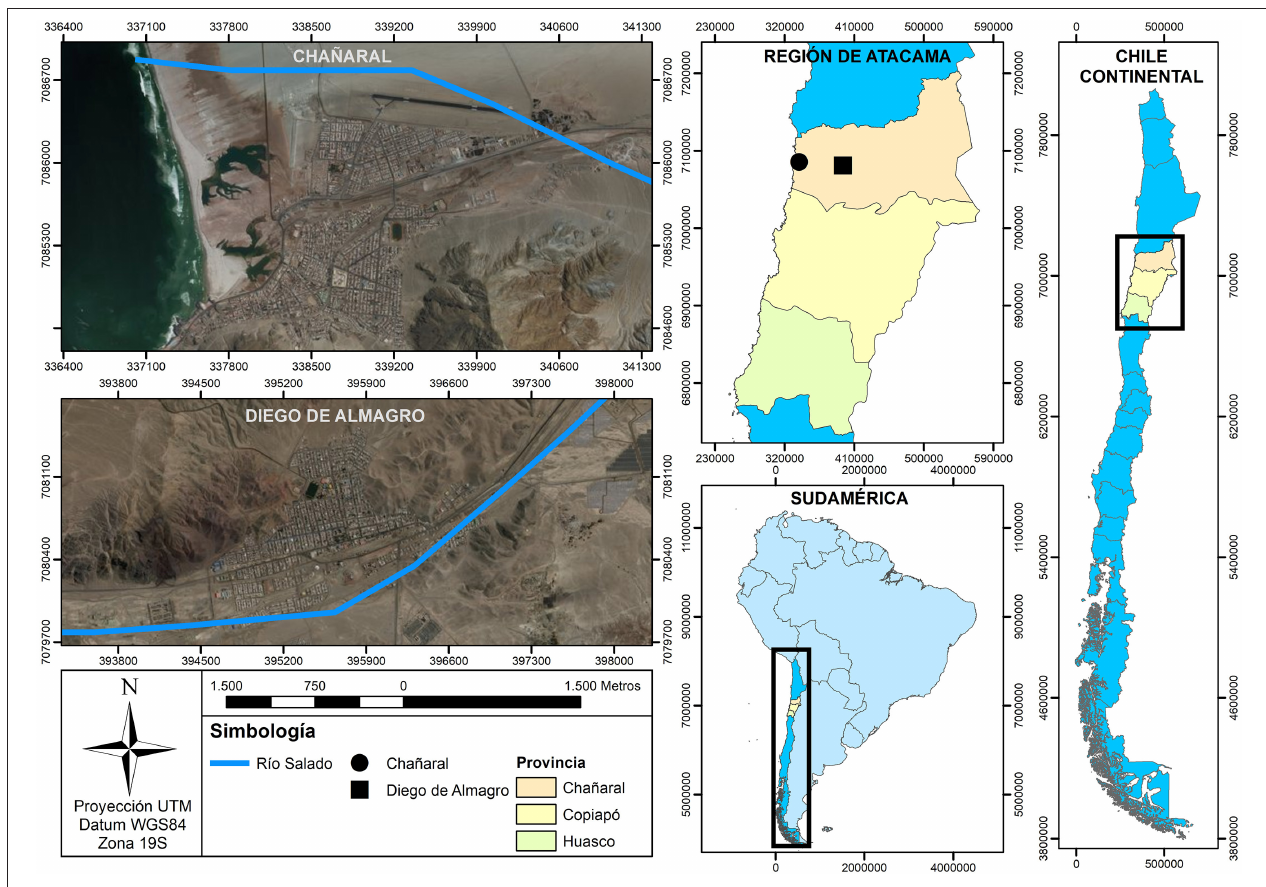
FIGURE 1 | Study area. Own elaboration. Source: Albers (2012), Porto (2015), and Infraestructura de Datos Geoespaciales